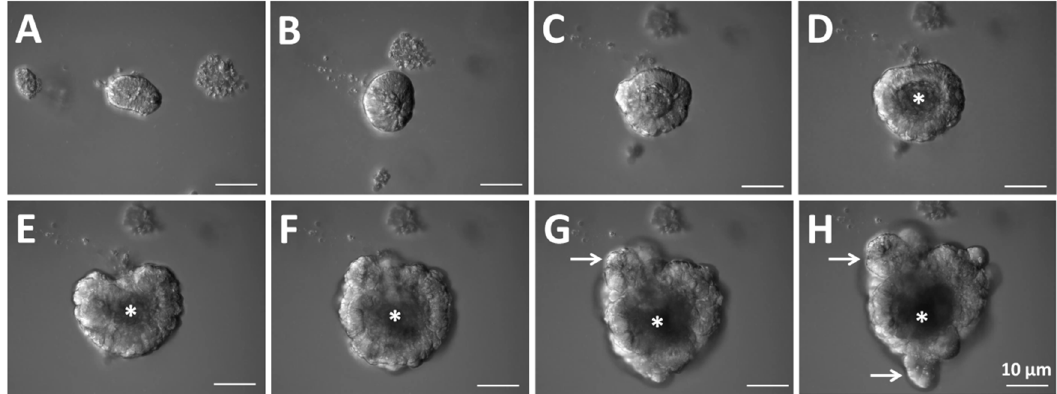
Figure 3. Representative images of a growing organoid derived from a crypt. ( A – C ) After the start of crypt culture, the upper opening rapidly become sealed. ( D – F ) Then, the lumen is filled with apoptotic cells. ( G , H ) The crypt region undergoes continuous budding events. ( D – H ) Asterisks indicate the lumen. ( G , H ) White arrows indicate crypt budding.